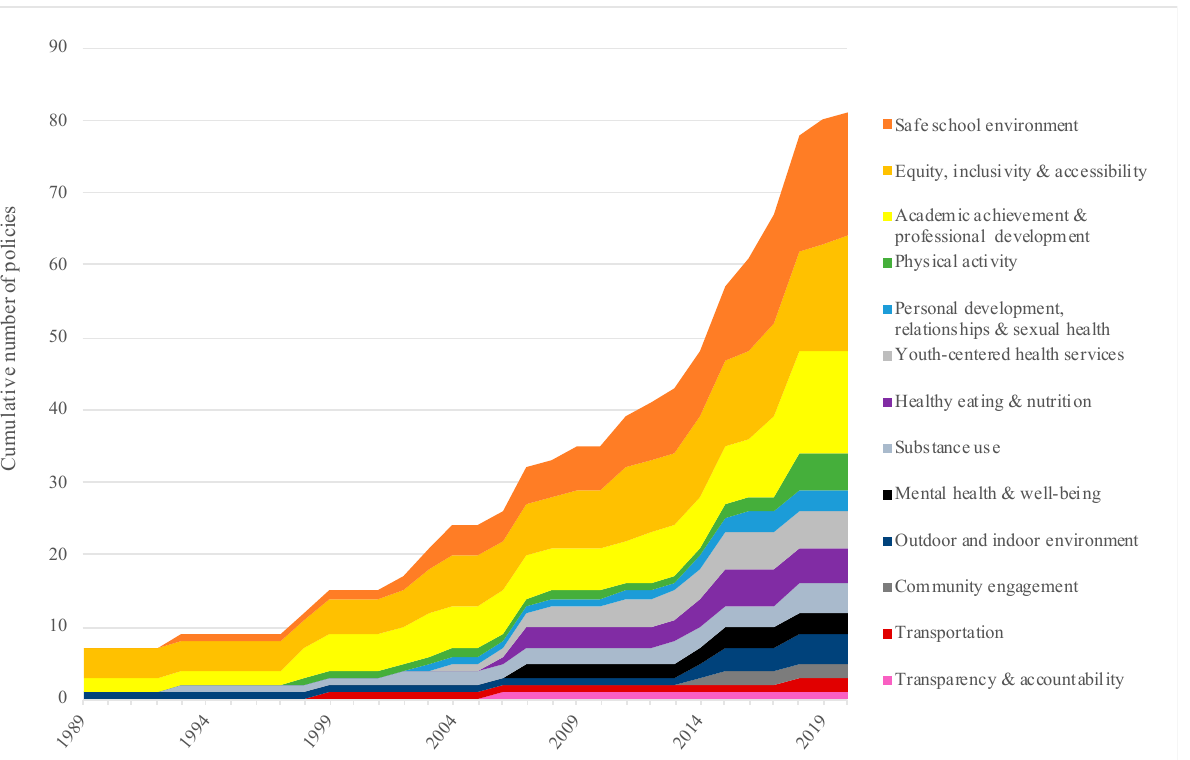
Figure 1. Proportion of Nova Scotia Provincial-Level Policies According to Health Promotion Topic Represented. Policies developed by Nova Scotia provincial government departments, including Education and Early Childhood Development; Nova Scotia Health; Communities, Culture and Heritage; Health and Wellness; Justice, and Transportation and Infrastruc- ture Renewal, are proportionally represented according to the health promotion topic(s) they were found to align with.